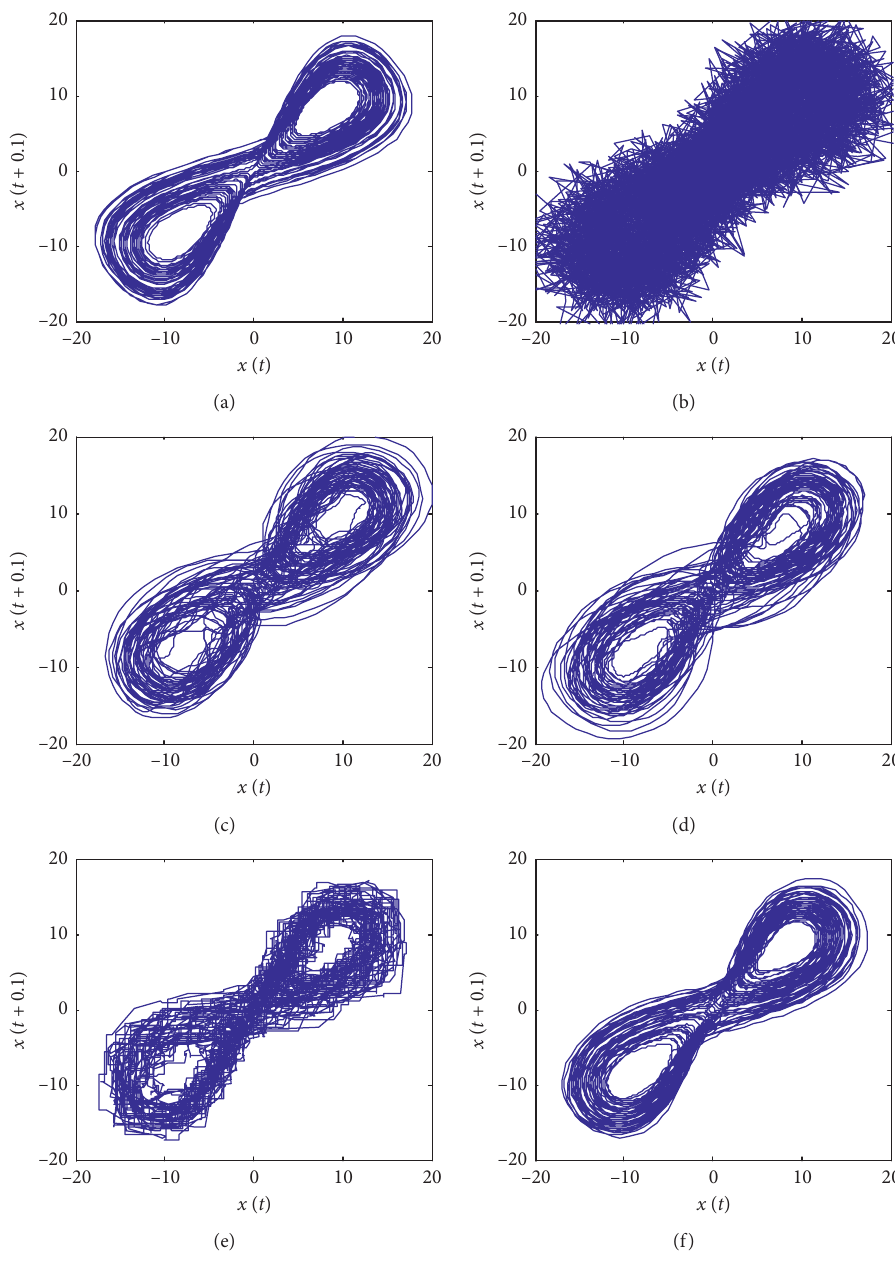
Figure 9: Phase diagram of Lorenz attractor: (a) original signal; (b) noisy signals; (c) signal denoised by EMD thresholding; (d) signal denoised by wavelet thresholding; (e) signal denoised by AMMF; (f) signal denoised by